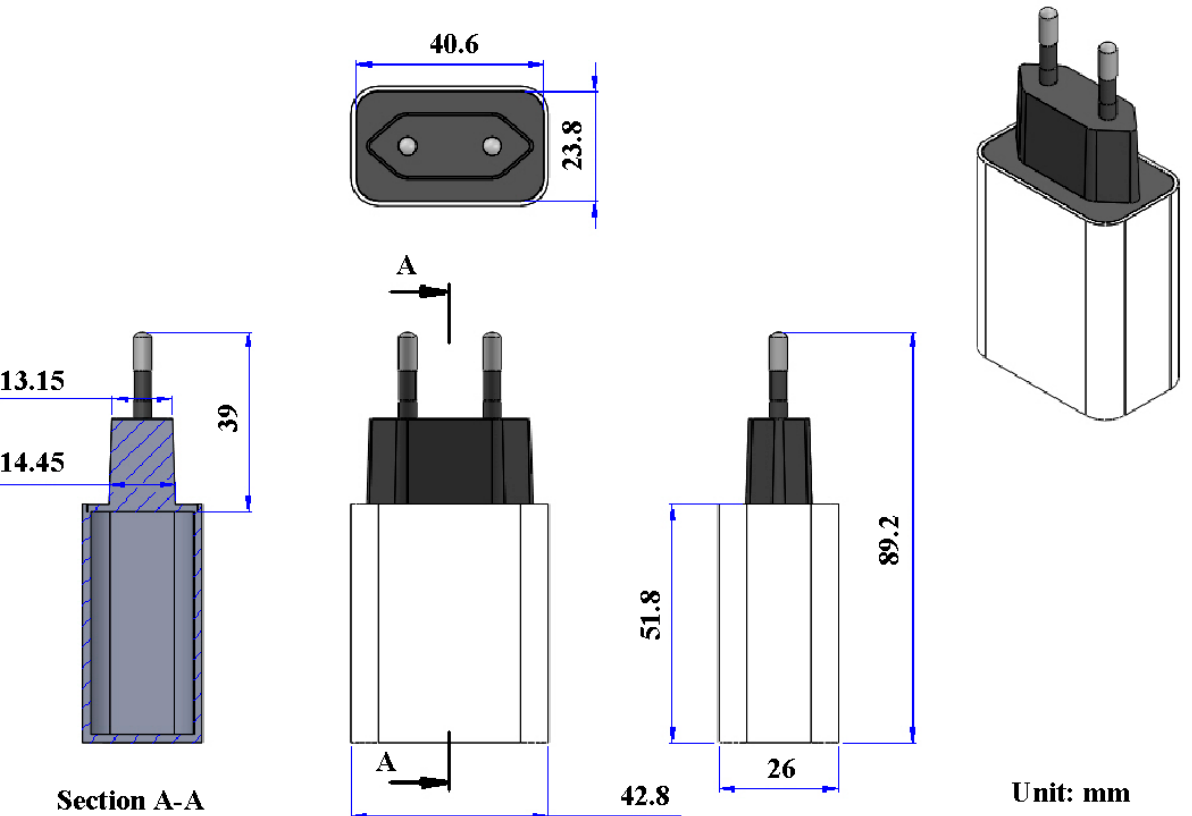
Figure 2. 3D CAD model and dimensions of a power case.